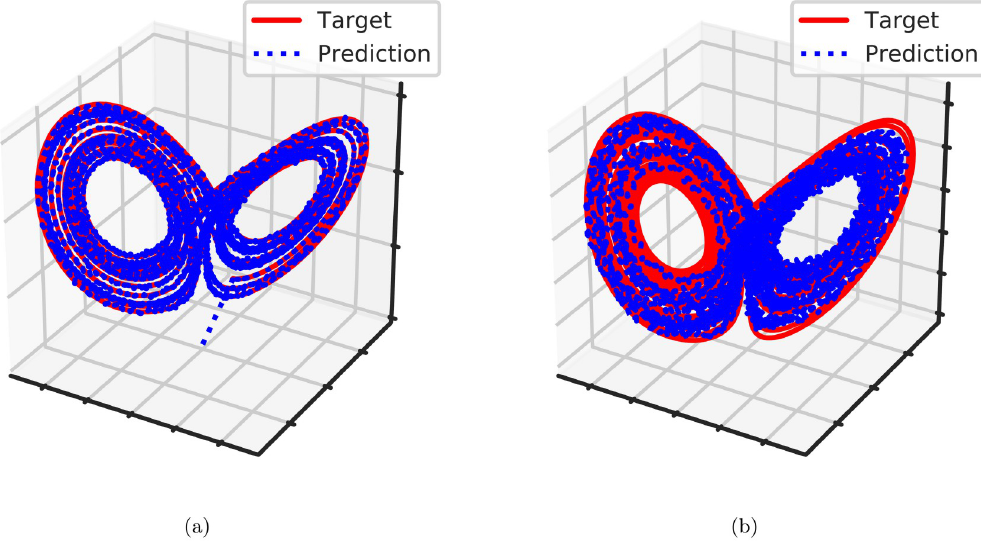
Fig 6. Trained Lorenz attractor dynamics in spiking networks. (A) Network output during training with FORCE updates every 50 time steps for T between 5 and 25 seconds. (B) Network output during inference ( T > 25 s ).